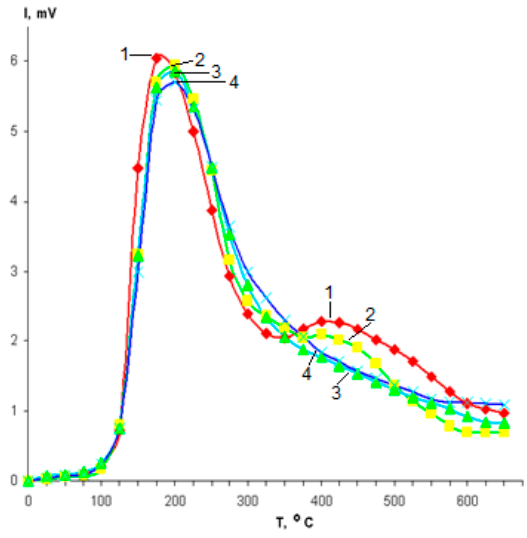
Figure 4. Thermal desorption spectrum of ammonia on H-ZKE-AF modified by 1–5% zinc sulfide: (1) pure H-ZKE-AF, (2) 1% ZnS additive, (3) 3% ZnS additive, (4) 5% ZnS additive.